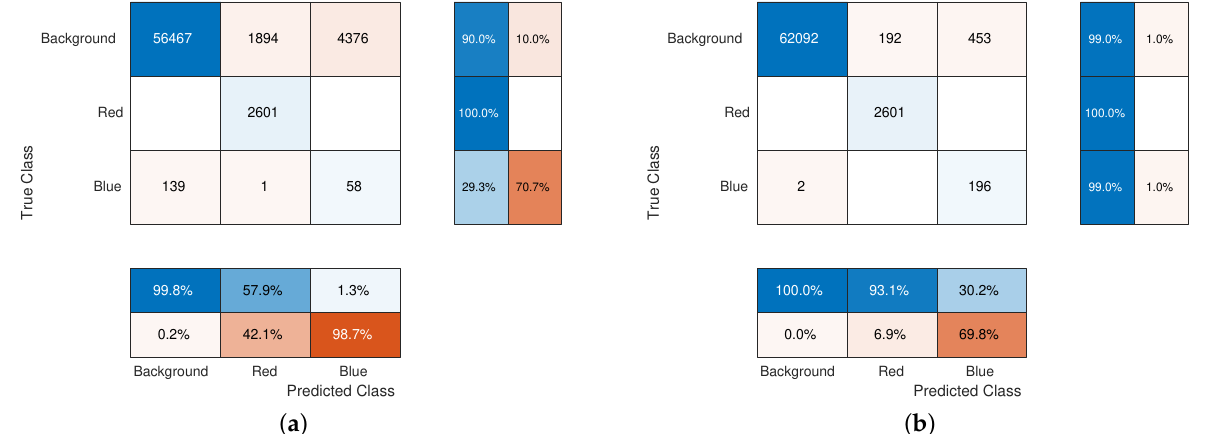
Figure 6. ( a ) confusion matrix with α = 0. ( b ) confusion matrix with α = 1, respectively. The influence of the similarity index is evident: its presence allows to decrease the percentage of background pixels classified as red and blue pixels from to 42.1% to 6.9% and from to 98.7% to 69.8%, respectively, while at the same time the performance of correctly labelled blue pixels increases from 29.3% to 99.0% (the success rate for the red ones is 100% in both